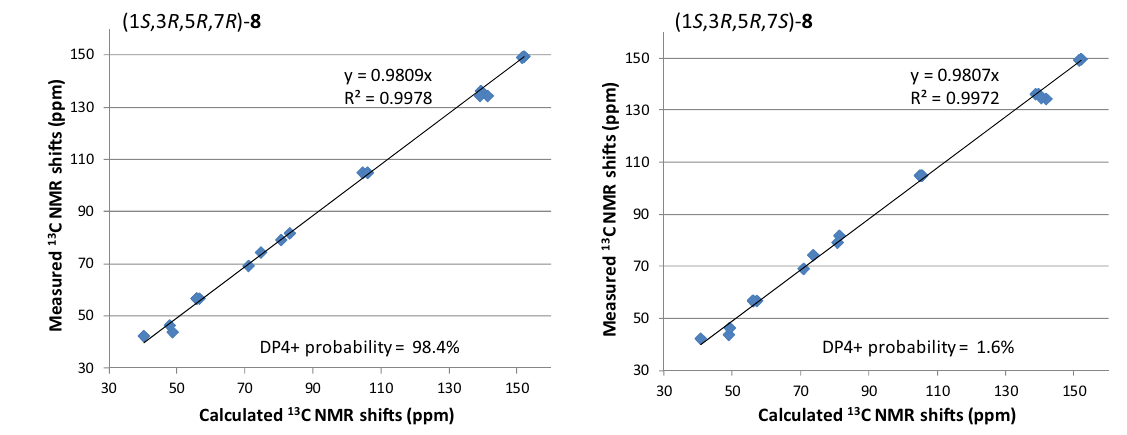
Fig. 7 Linear regression analysis of the calculated 13 C NMR shifts of two possible stereoisomers against the measured shifts of 8 and the DP4 + probability for 8 to be the stereoisomers